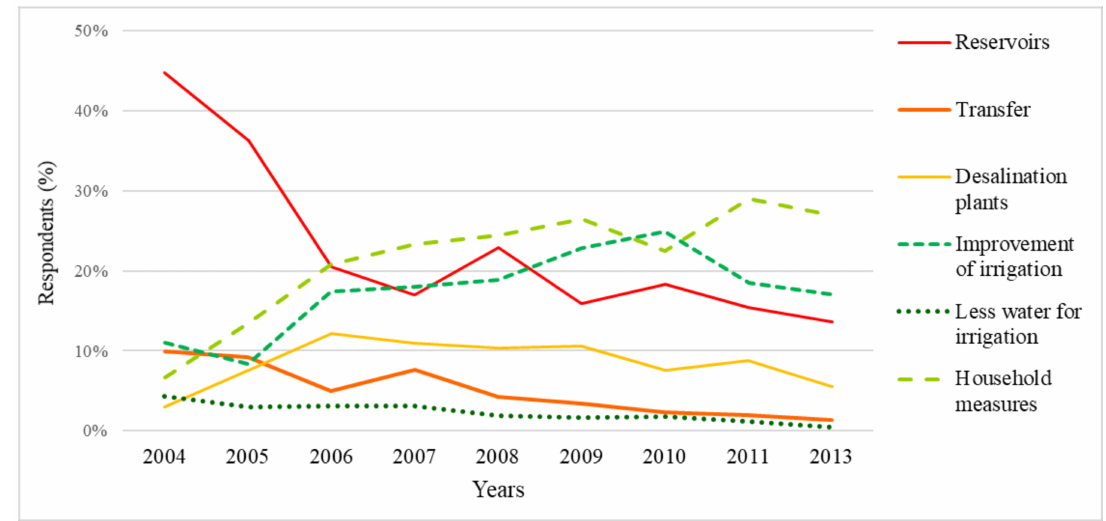
Figure 2. Support for water management measures in Andalusia 2004–2013 (%). Source: Authors’ own after Ecobar ó metro de Andalucia (EBA)